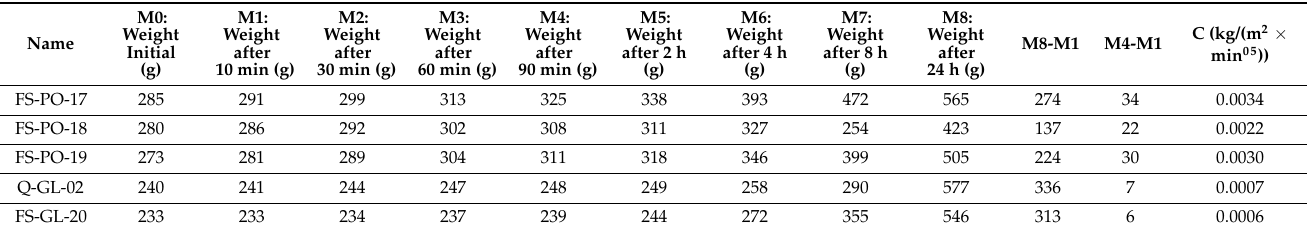
Figure 10. Three-point flexural test of bleached cellulose pulp compared to blend of bleached cellulose pulp with beech sawdust.